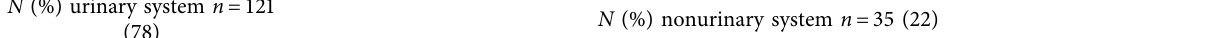
Table 5: Te distribution of factor-toxin genes of 156 ExPEC isolates by clinical origin/the virulence factor distributions in the urinary and nonurinary tract foci in CDT - and CNF -positive ExPEC isolates.